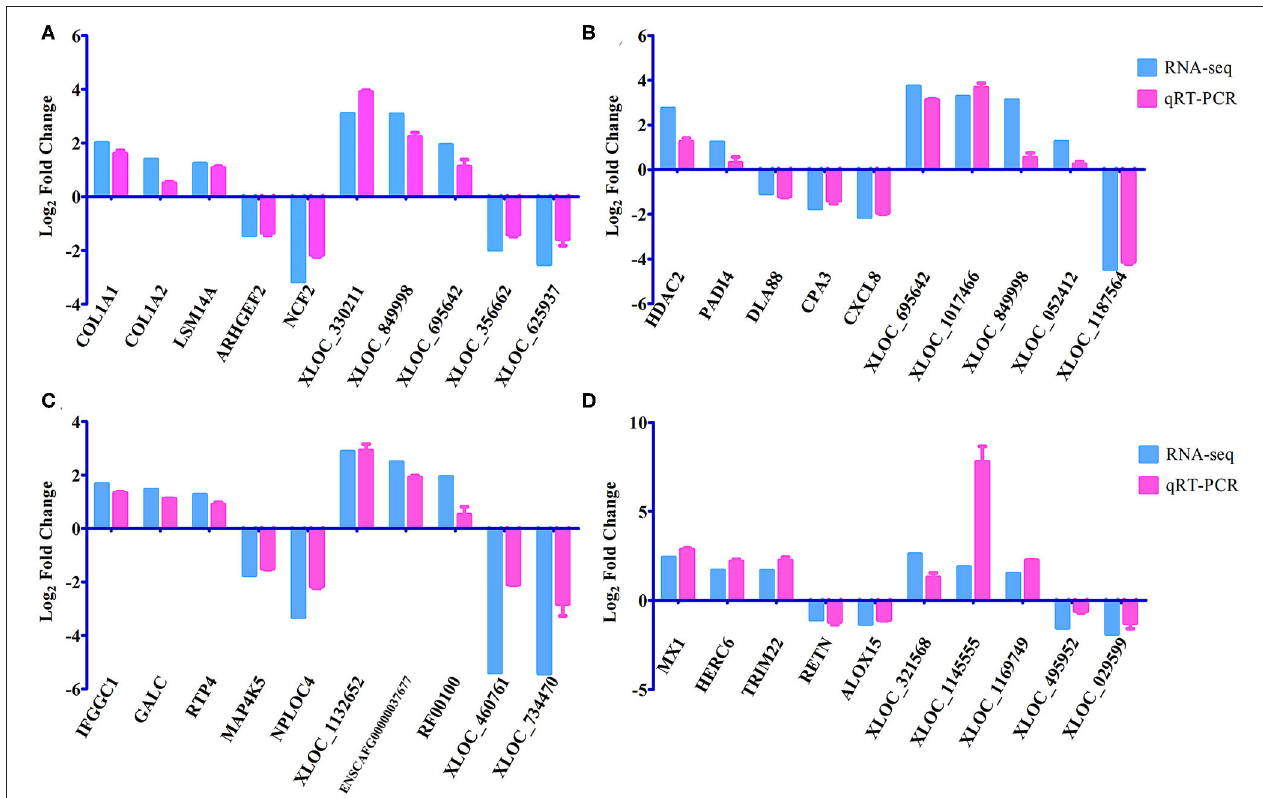
FIGURE 4 | Verification of the expression of DEmRNAs and DElncRNAs using qRT-PCR at (A) 12 hpi, (B) 24 hpi, (C) 96 hpi, and (D) 36 dpi. The Y-axis denotes the log 2 fold change, and the X-axis shows the analyzed DEmRNAs and DElncRNAs. The error bars represent the standard deviation based on three